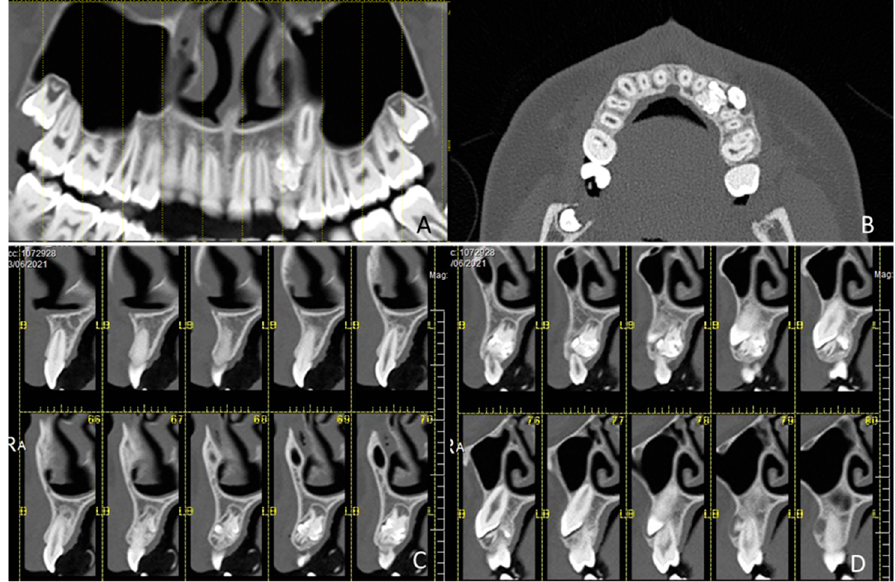
Figure 1. Series of images from cone beam computed tomography (CBCT). ( A ) Orthopanoramic CBCT view shows the persistence in the arch of the upper left deciduous canine 63 and the overlapping presence of a compound odontoma, which in its evolution blocked the eruption of the corresponding permanent canine; ( B ) A cross-section image highlights the permanent canine that has been displaced vestibular due to the presence of an odontoma that is palatal to the canine; ( C , D ) Parasagittal images that show that the odontoma completely occupies the entire thickness of the bone between the buccal and palatal cortex. Absence of bone trabeculae and displacement of the permanent canine towards the vestibulum.